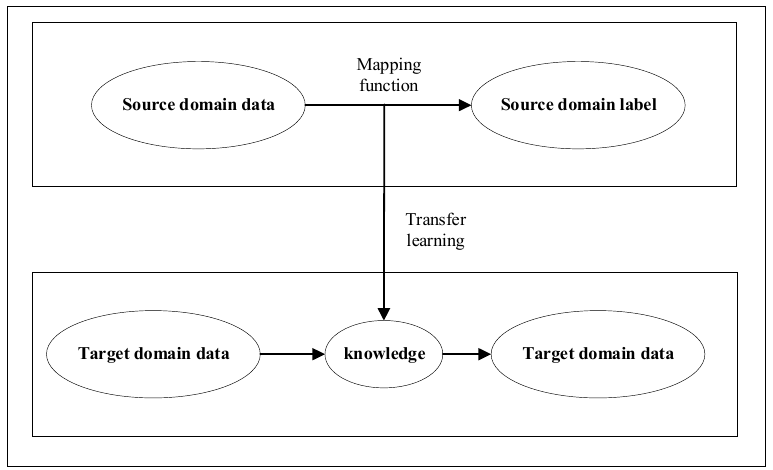
Figure 2. Schematic diagram of transfer learning principle.